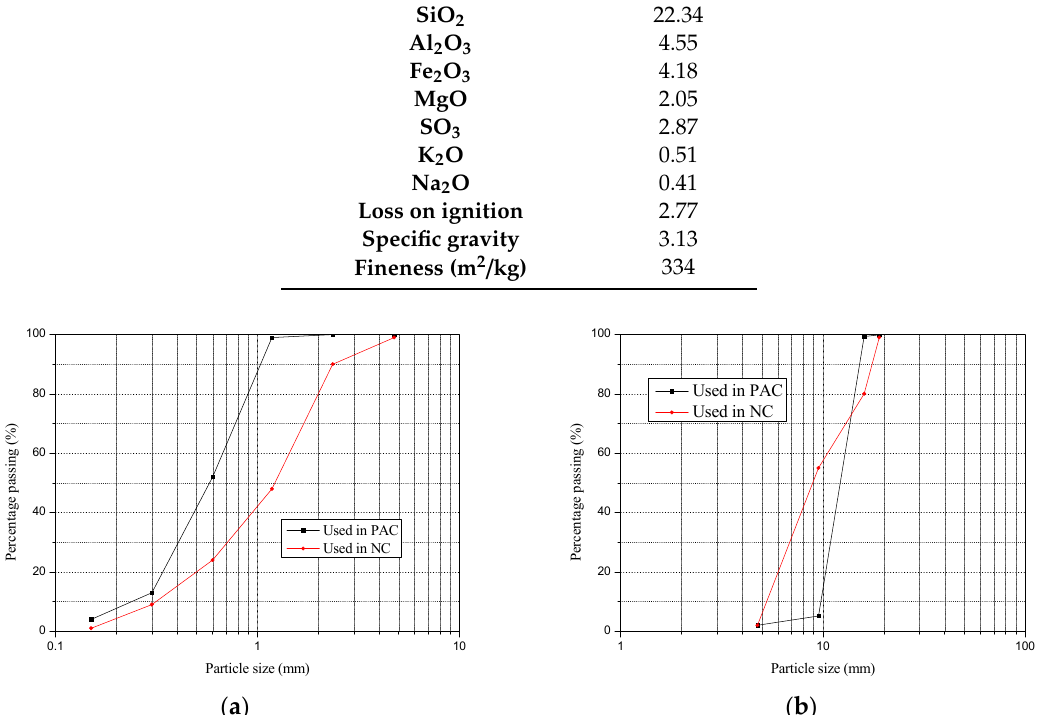
Figure 1. Particle size distribution of sand and coarse aggregate. ( a ) Sand, ( b ) Coarse